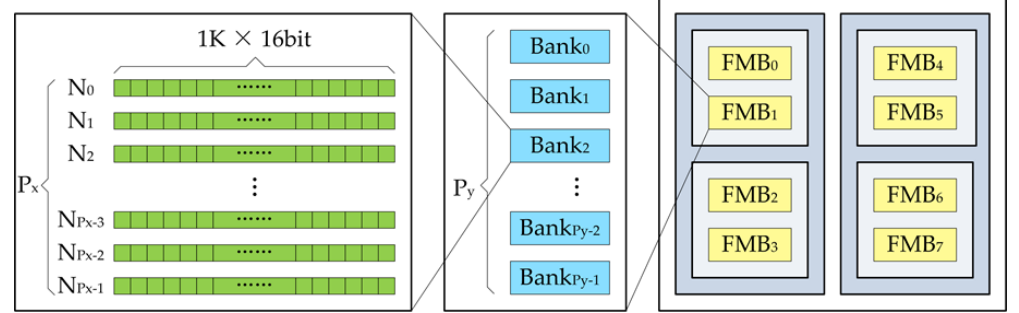
Figure 6. The hierarchical storage organization of the feature maps buffer.